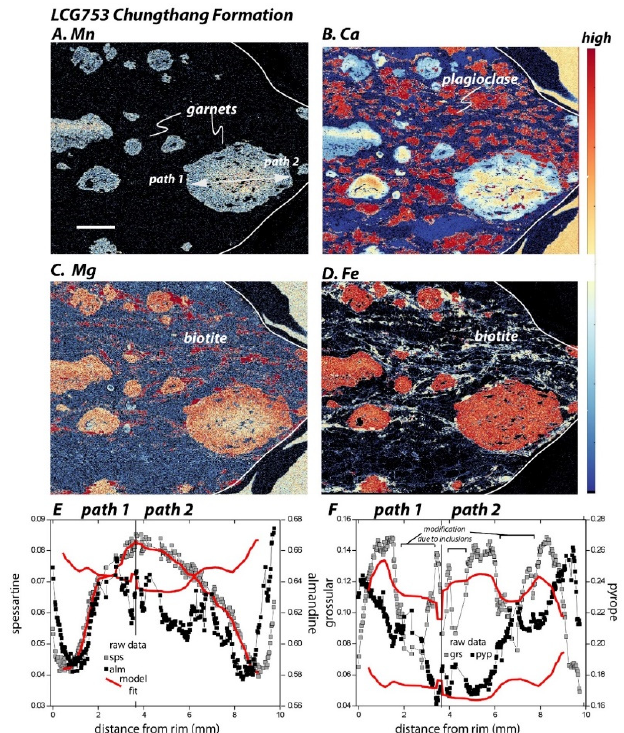
Figure 9. X-ray element maps of sample LCG753 (Chungthang Fm) in ( A ) Mn, ( B ) Ca, ( C ) Mg, and ( D ) Fe. Garnet compositions in spessartine (sps) and almandine (alm) (panel E ) and grossular (grs) and pyrope (pyp) (panel F ) were taken across the rim to rim transects identified in panel ( A ). The red lines in panels ( E ) and ( F ) show the prediction of the high-resolution P-T paths generated for this sample. Areas on the garnet speculated to be affected by diffusional modification are indicated on panel ( F ).